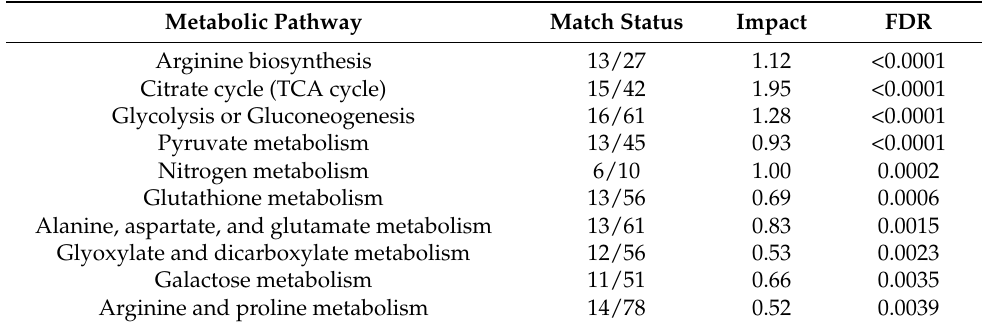
Table 1. Most significant metabolic pathways in the gut modulated during cryptosporidiosis with respect to the uninfected mice, based on integration of the metabolomics and proteomics data using a joint pathway analysis